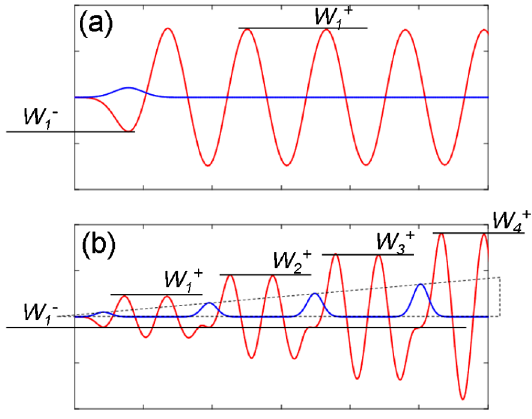
FIG. 1. The ramped bunch train (RBT) method used to gen- erate the transformer ratio, R > 2 . (a) The single bunch wake- field (red) due to a Gaussian drive beam (blue) yields ¼ W þ =W (cid:1) ¼ 2 . (b) For this structure, a train of four R 1 1 1 Gaussian drive bunches (blue) with an overall triangular pattern (dotted line) is moving to the left. Bunches are separated by distance d ¼ 2 : 5 (cid:1) (in general, multiples of 0 : 5 (cid:1) ), where (cid:1) is the wavelength of the wakefield. The ratio of the charge is 1:3:5:7 ; the transformer ratio increases as R n ¼ W þ n =W (cid:1) 1 ¼ 2 n . This is only exactly true at the bunch